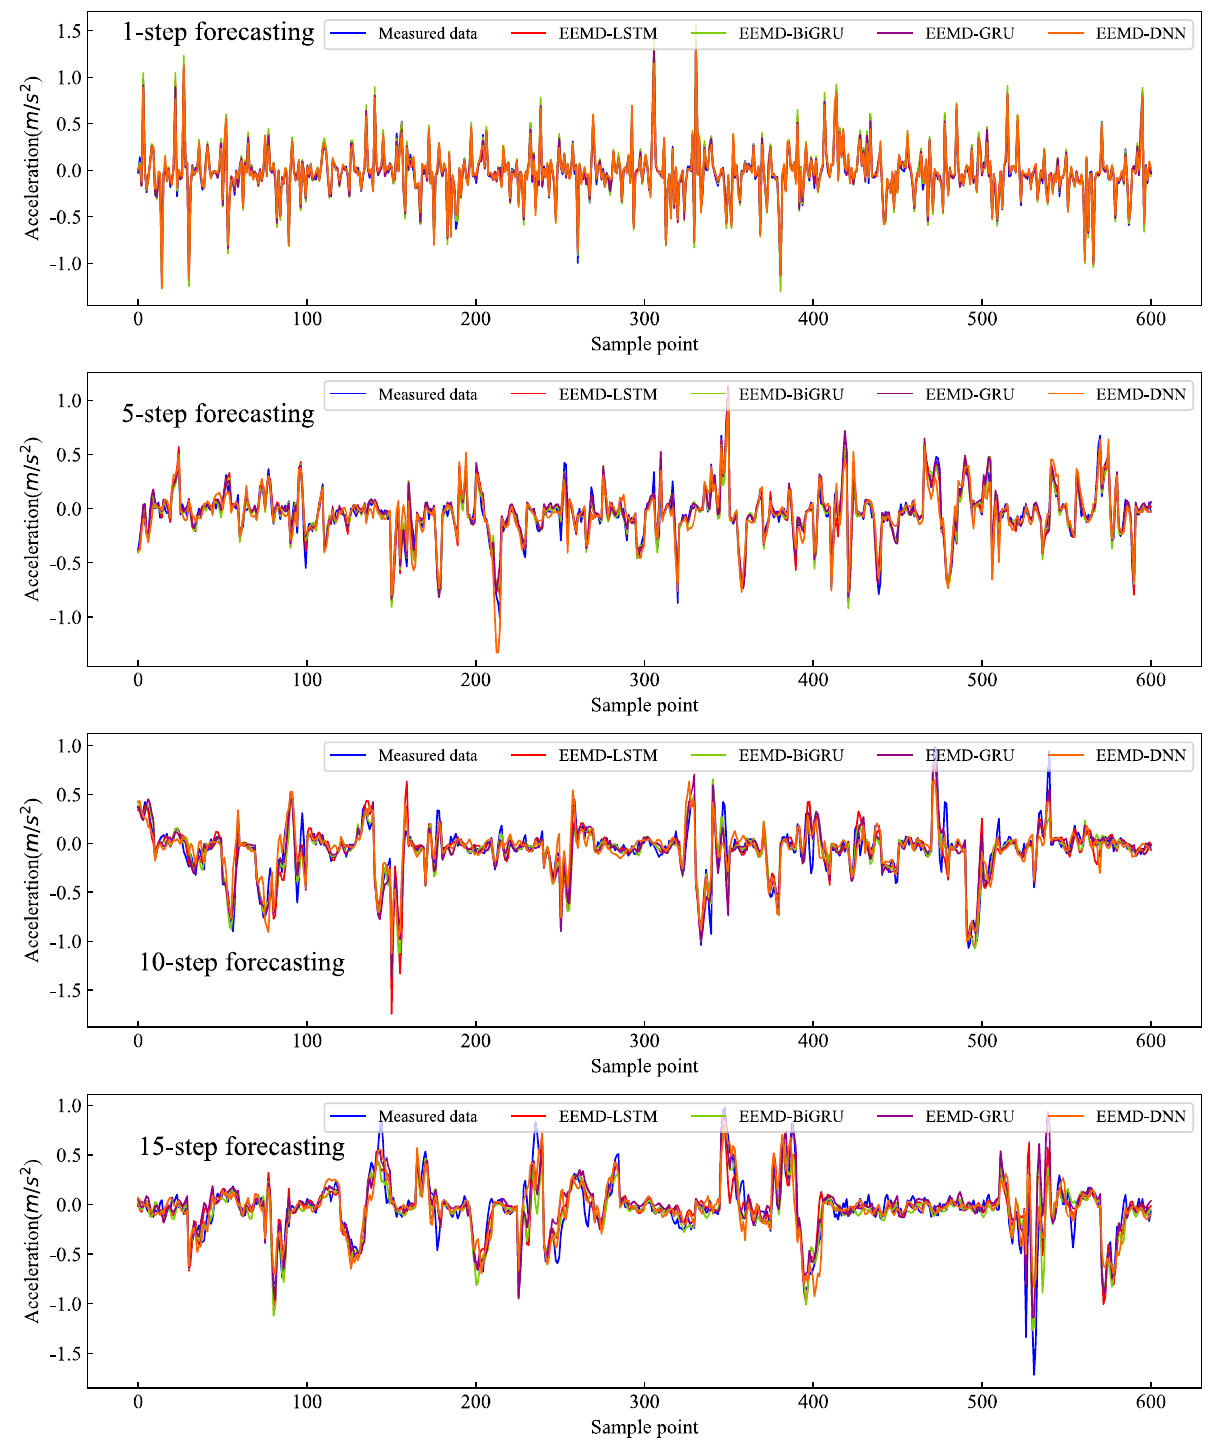
Figure A3. Comparisons results for the RG dataset using the EEMD-based algorithms (from top to bottom, the order is 1-step forecasting, 5-step forecasting, 10-step forecasting, and 15-step forecasting).